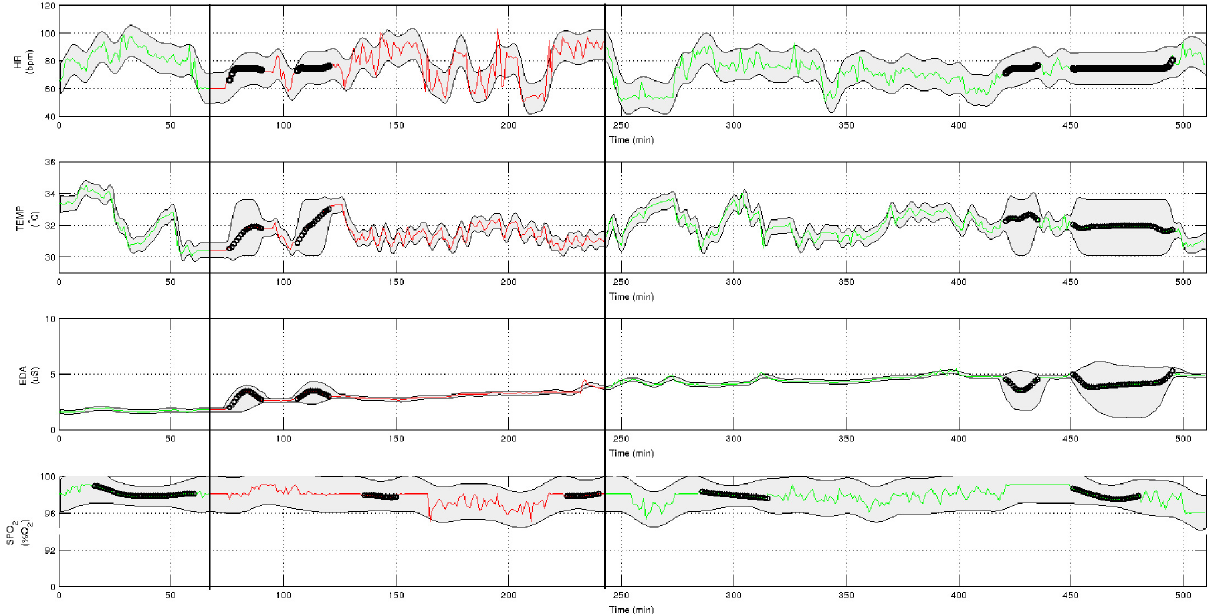
Figure 4. Gaussian process machine learning (GPML) and data synchronization applied during a migraine episode.